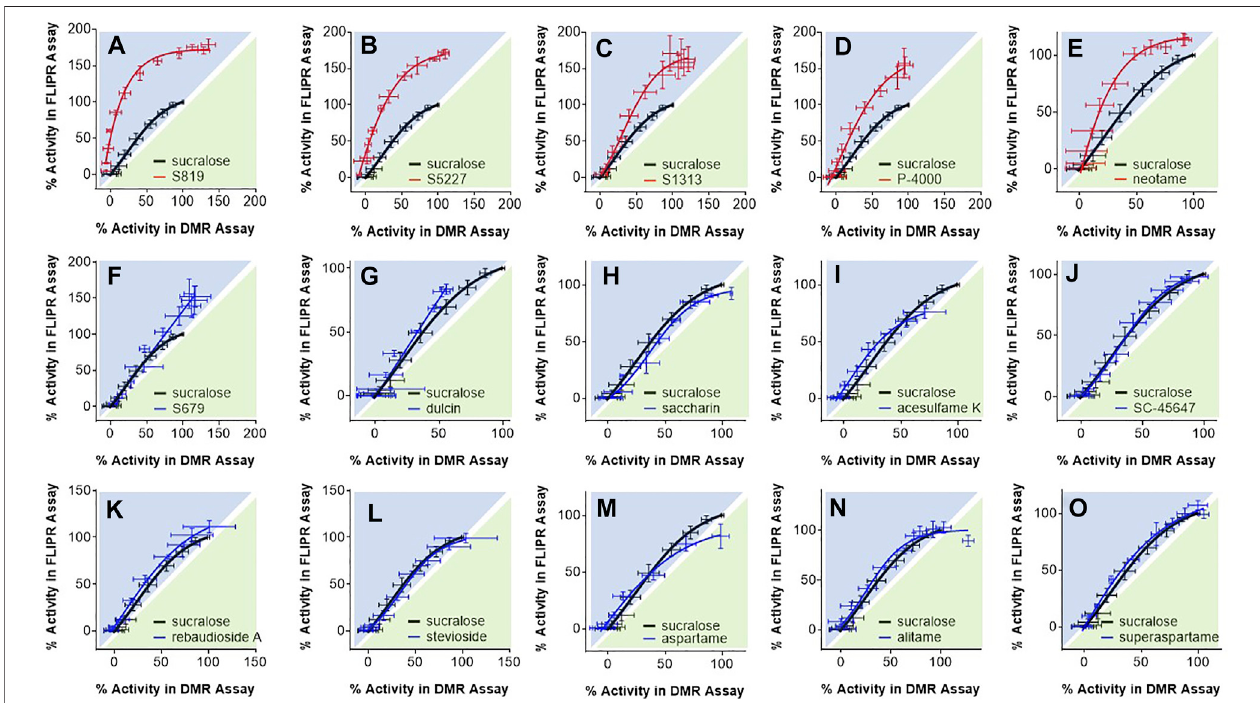
FIGURE 5 | Bias plotting analysis. Depicted agonists [panels (A – O) ] were evaluated at equimolar concentrations in the DMR assay with R2/R3 U2OS cells and in the FLIPR assay with R2/R3 U2OS cells expressing G α 15 . Assay data was normalized to responses obtained with 1 mM sucralose and resulting activity values were plotted on the same graph. Each data point corresponds to an average and standard deviation from values generated in 3 to 21 independent experiments performed in triplicate.